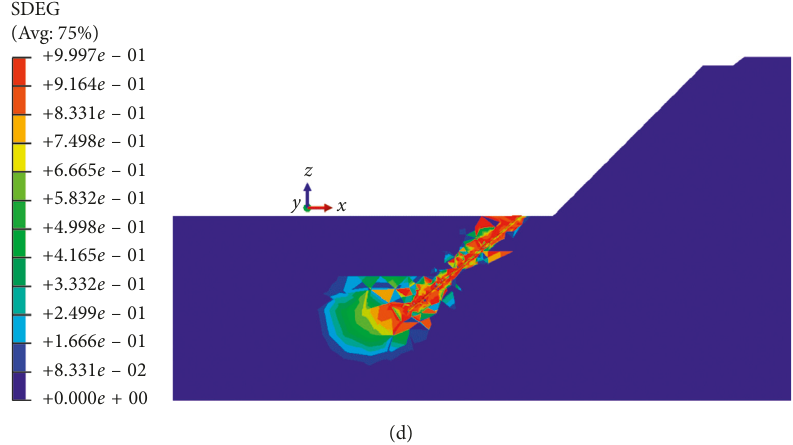
Figure 7: Time history contours of the slope damage factors after blasting at (a) 1ms, (b) 3 ms, (c) 5ms, and (d) 7 ms.